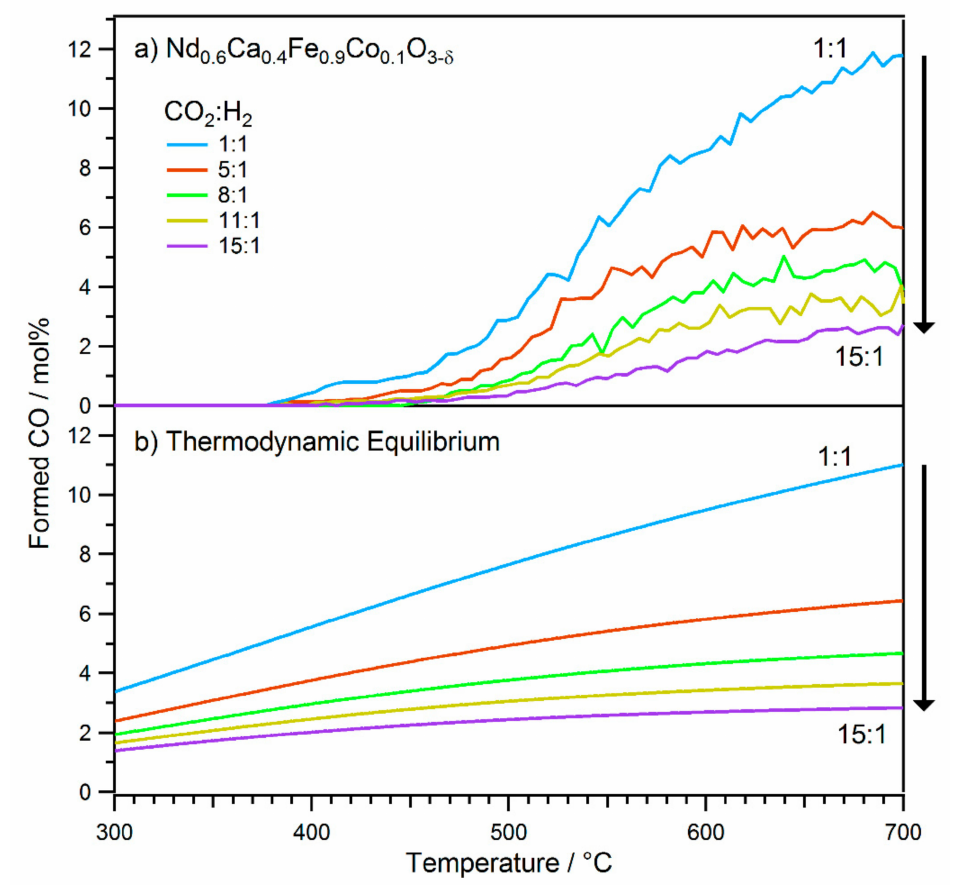
Figure 2. Comparison of different CO 2 to H 2 ratios (from 1:1 to 15:1) that were used in rWGS reactions. ( a ) Experimental results of the reaction on Nd 0.6 Ca 0.4 Fe 0.9 Co 0.1 O 3- δ . In all experiments, the temperature was increased using a linear ramp of 80 ◦ C h − 1 between 300 ◦ C and 700 ◦ C. With decreasing H 2 content, less CO was formed during reaction. ( b ) Calculated equilibrium concentrations of CO, marking the thermodynamic